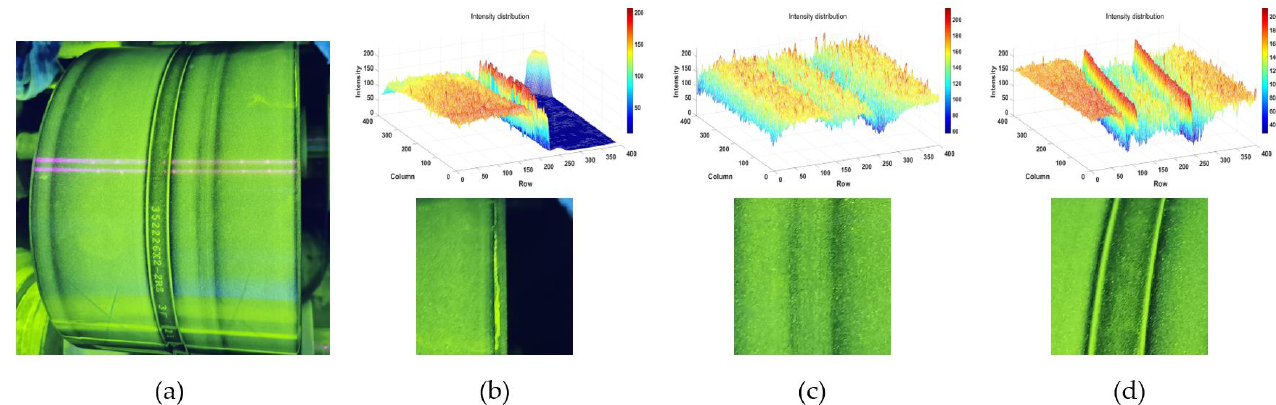
Figure 1. The inspection image of the bearing ring and corresponding magnetic particle distribution. ( a ) The inspection image of bearing ring; ( b ) Crack indication and corresponding intensity distribution; ( c ) Randomly distributed magnetic particles and corresponding intensity distribution; ( d ) False indications and corresponding intensity distribution.